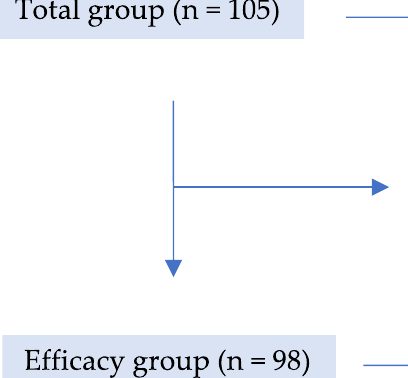
Figure 1. Patient disposition.